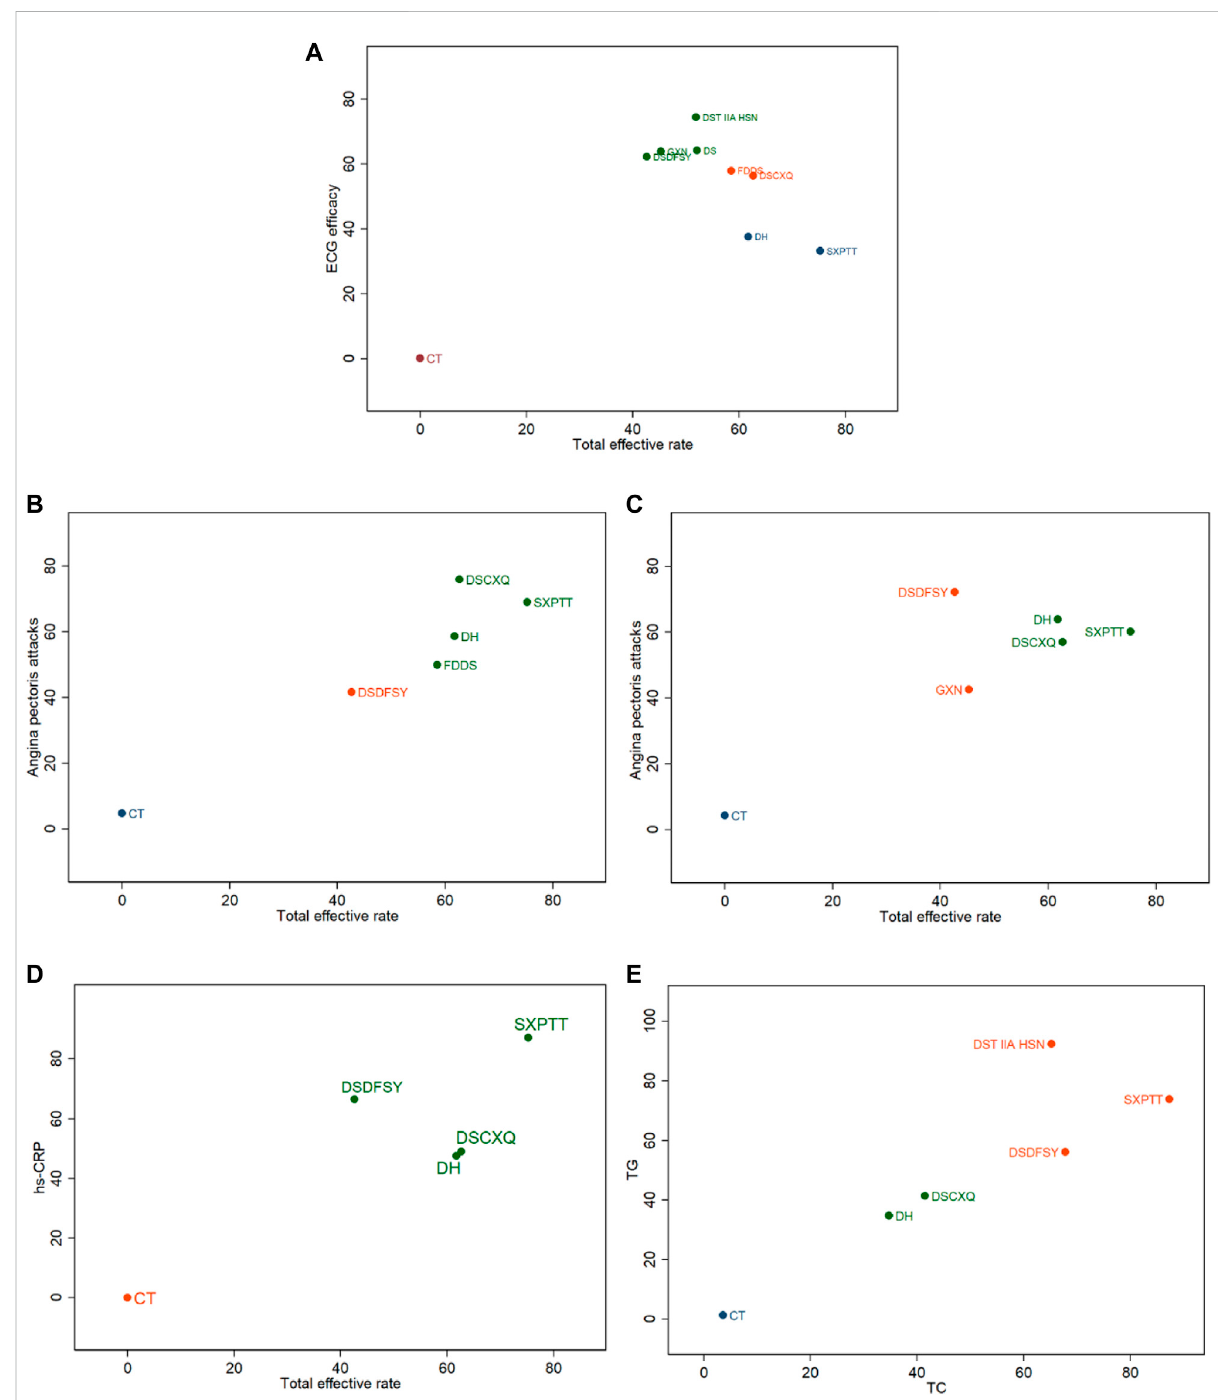
FIGURE 7 Cluster analysis of comparisons on different outcomes of treatments in different groups of patients with UA. (A) total effective rate and ECG ef fi cacy; (B) total effective rate and Angina pectoris attacks (weeks); (C) total effective rate and Angina pectoris attacks (days); (D) total effective rate and hs-CRP; (E) TC and